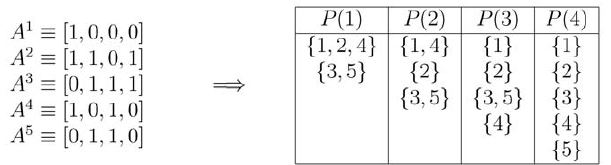
Figure 1. Illustration of the classifications made by a preju- diced individual as a function of her level of prejudices. On the left, we show the DNA sequence of five players, and on the right, the way these players would be categorized by a prejudiced individual according to its level of prejudice. A very prejudiced player, P (1) , only observes the first attribute, and hence forms coarse groups. P (4) , on the other hand, observes all four attributes and, since no two individuals share the same DNA, treats each individual as unique.